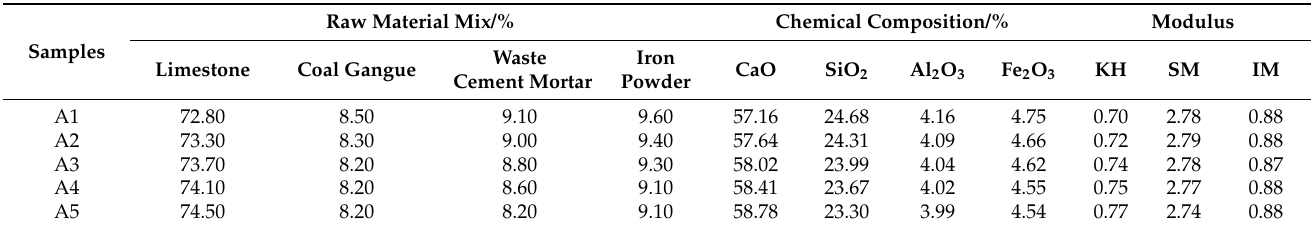
Table 2. The composition of low waste mortar raw meals without the addition of SO 3 in wt.% and expected basic chemical parameters.